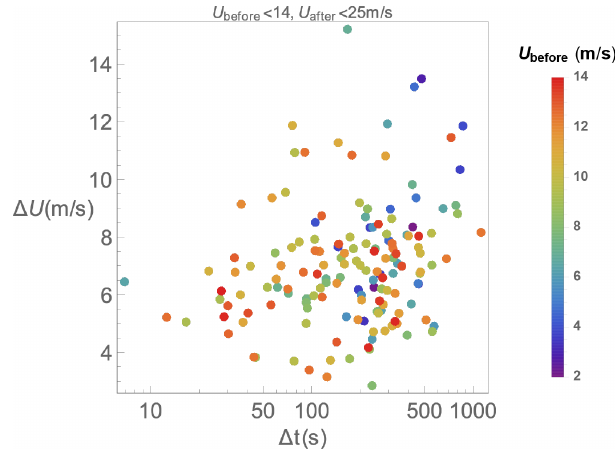
Figure 5. Ramp event occurrence, in terms of (cid:49)t(cid:49)UU before